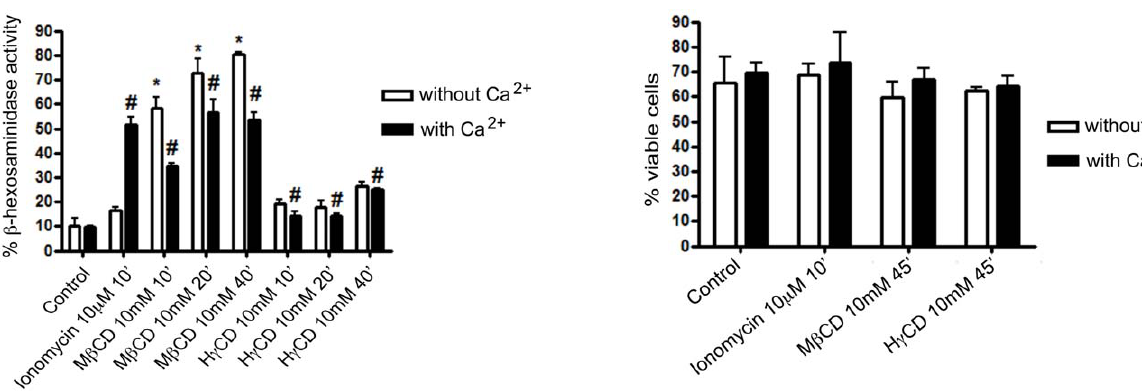
Figure 4. M b CD but not H c CD cell incubation leads to lysosomal exocytosis in cardiomyocytes. Cardiomyocytes were exposed to either 10 mM M b CD or H c CD for 10, 20 or 40 minutes at 37 u C, in the absence (white bars) or presence (black bars) of calcium. Both extracellular media and lysates were collected and exposed to 4- methylumbelliferyl-N-acetyl-B-D-glucosaminide, the fluorescent sub- strate of beta-hexosaminidase, an enzyme resident within lysosomes. Results are shown as ratio between b -hexosaminidase activity in extracellular media and total b -hexosaminidase activity (extracellular media over extracellular media plus b - hexosaminidase cell lysate hexosaminidase activity). Cells treated with 10 m M Ionomycin (Calbio- chem) for 10 minutes were used as lysosomal exocytosis positive control. Data are shown as mean of triplicates 6 SD. Asteriks indicate statistically significant differences (p , 0.05,Student’s t test) between control and treated cells.